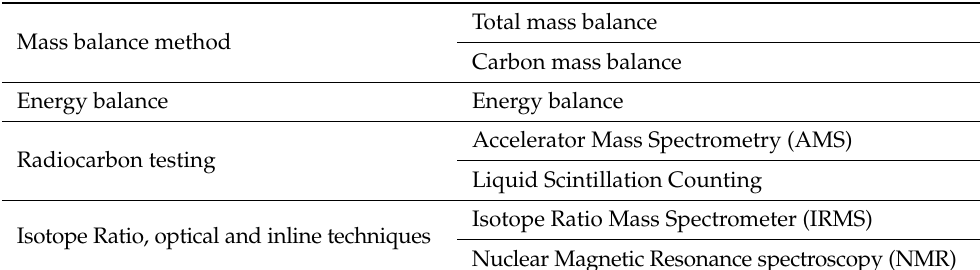
Table 2. Methods to determine the bio-content in